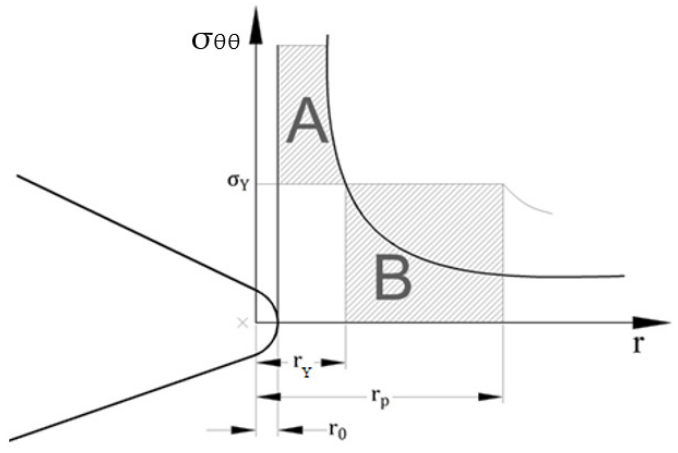
Figure 3. Schematic of the elastic tangential stress variations on the notch bisector line versus the distance from the notch tip.